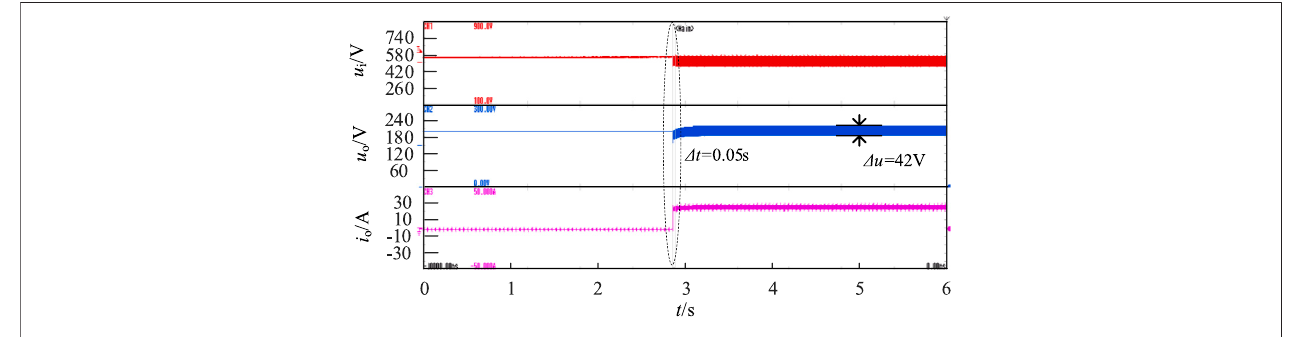
FIGURE 12 | Experimental waveforms for the proposed RBFNN control strategy.